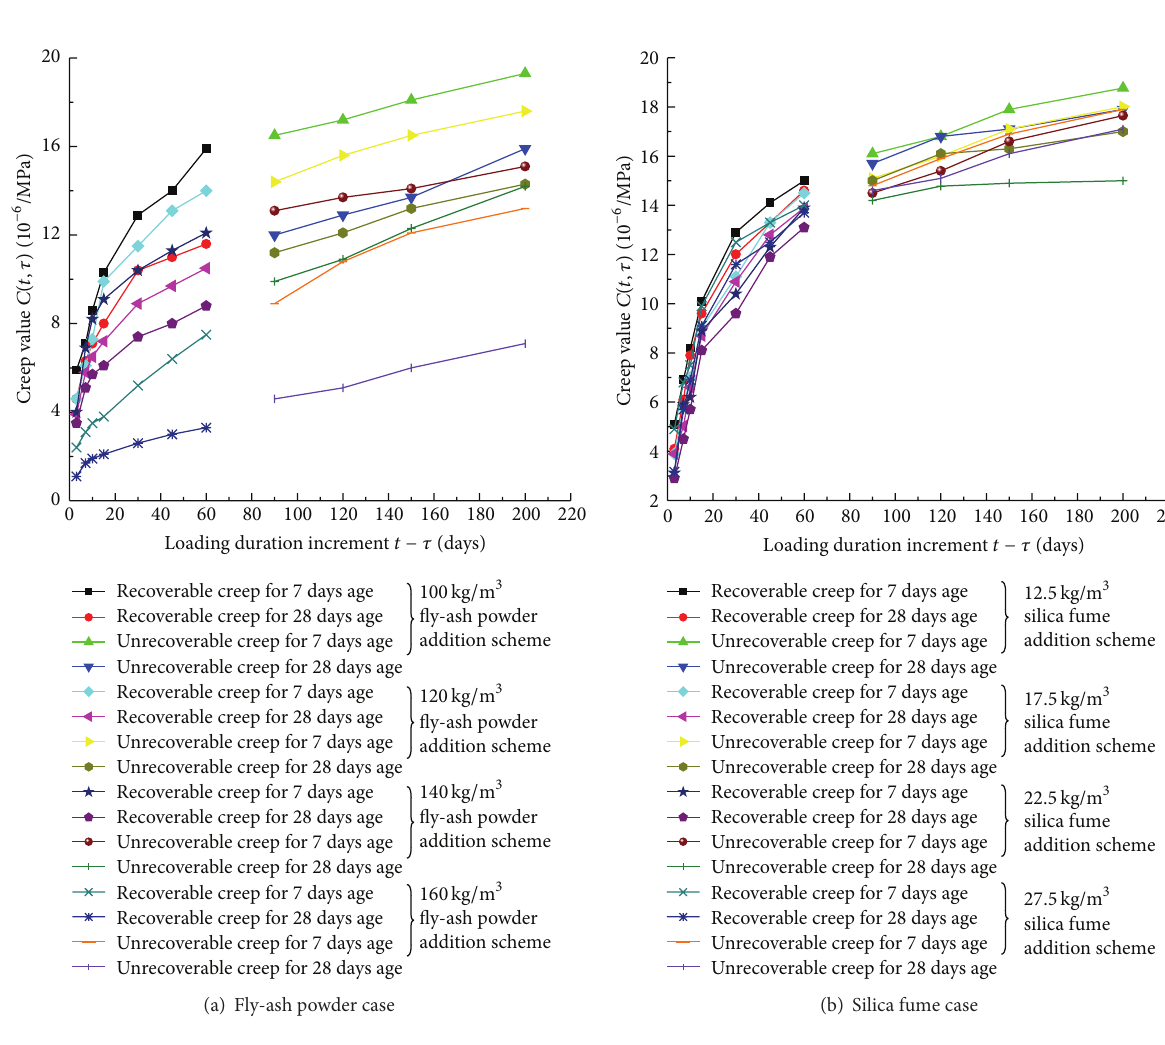
Figure 16: Sensitive curves of creep